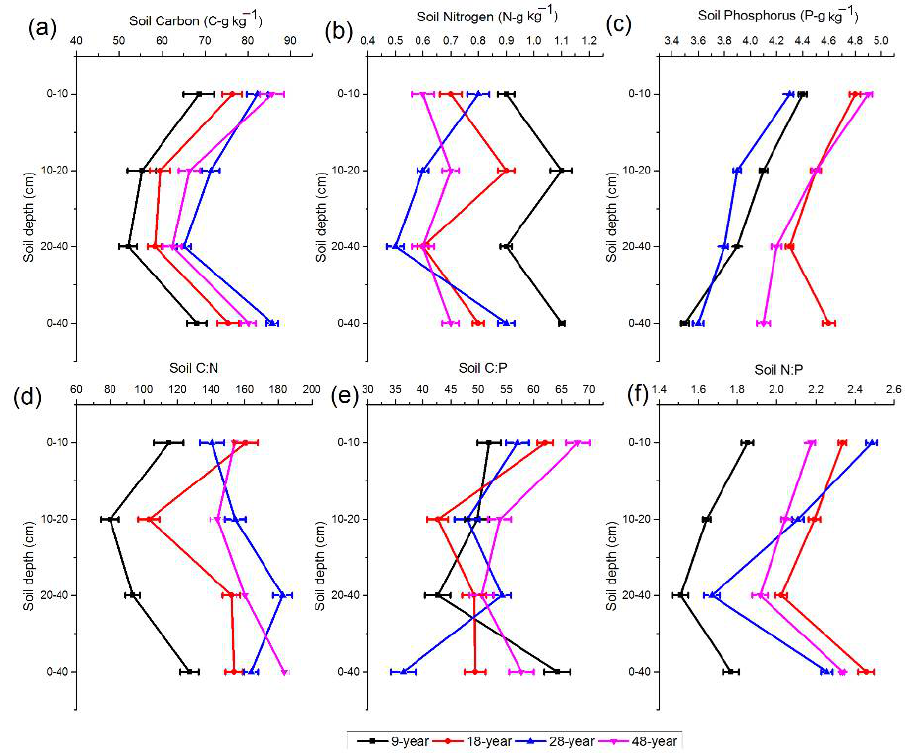
Figure 3. Changes in contents of soil carbon (C), nitrogen (N), and phosphorus (P) ( a – c ) and stoi- chiometric ratios ( d – f ) in a Masson pine chronosequence and within soil layers (0–40 cm). Error bars show standard error while the lines represent mean value with three replicates.